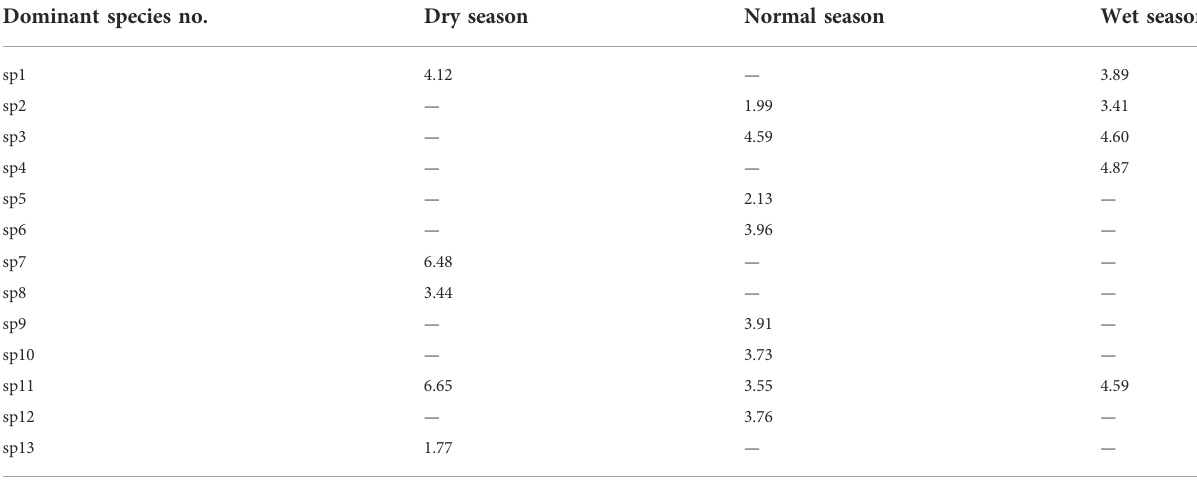
TABLE 3 Variations in the niche width (B i ) of the dominant phytoplankton species in different hydrological seasons. Dominant species